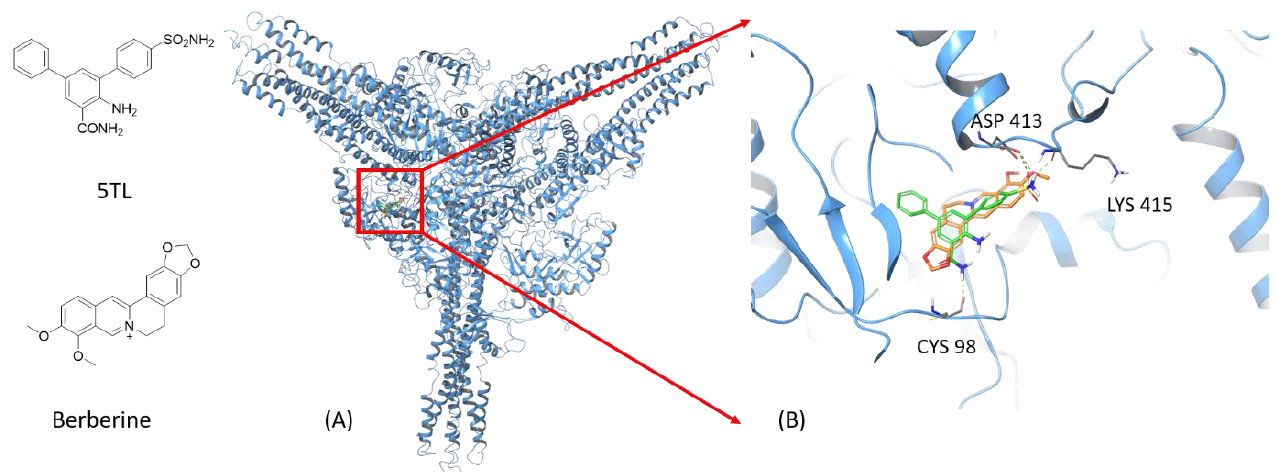
Figure 7. Docking results of BBR and 5TL to IKKα. Hydrogen bonds were interpreted as yellow dash lines. Carbons in 5TL were coloured green and those in BBR were coloured gold. All non-polar hydrogens were hidden. The structures of 5TL and BBR, the binding of both ligands ( A ) and the focused binding site of both ligands ( B ) are shown in the figure.